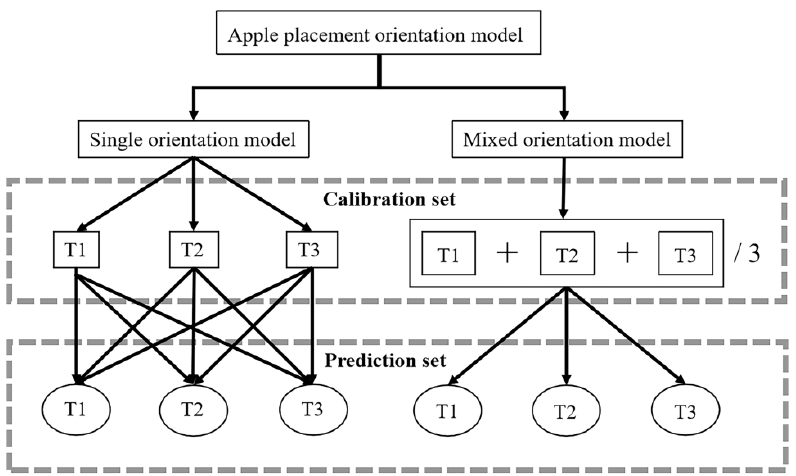
Figure 5. Experimental scheme of single-orientation models and all three orientation models.